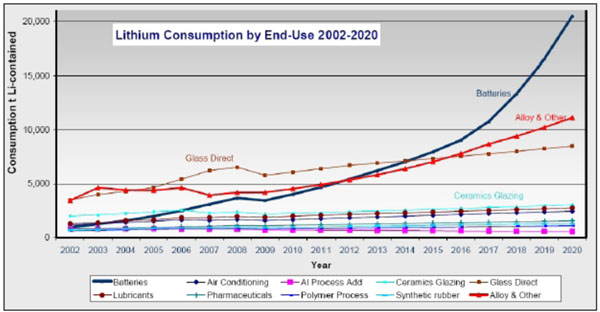
Lithium Consumption by End-Use 2002-2020 [7]